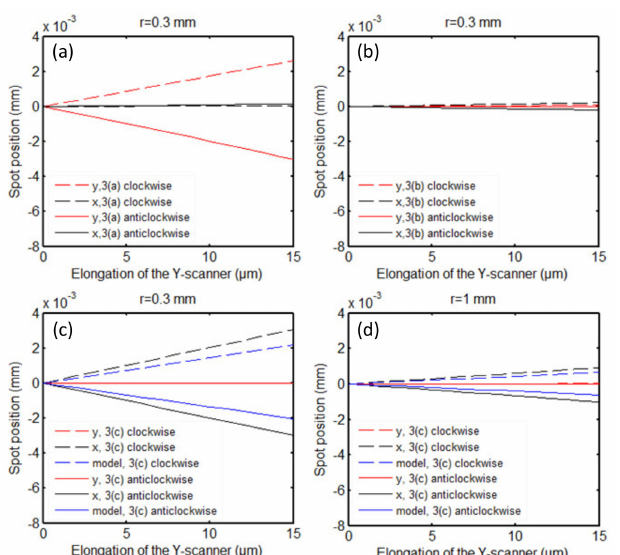
Figure 7. The simulation results of the laser spot movement on the QPD were caused by the extension of the oblique-mounted Y-scanner. ( a – c ) The results produced by the Y-scanner movement. When the scanner is mounted obliquely, as shown in Figure 3a–c, the radius of the laser spot on the QPD is 0.3 mm. ( d ) The radius of the laser spot on the QPD is 1 mm. The dotted lines and solid lines indicate that the Y-scanner is mounted obliquely clockwise and anticlockwise, respectively. The blue lines represent the theoretical curve of Formula (1). The tilt angle used in the simulation is 2 ◦